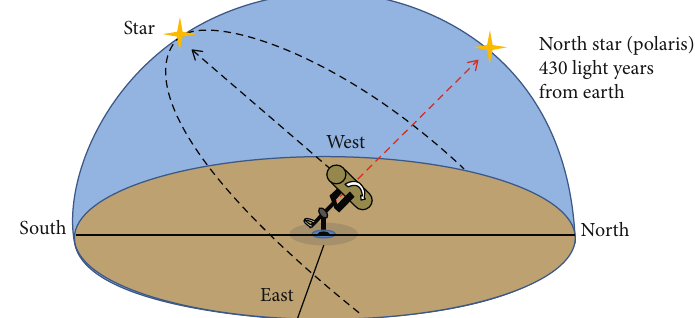
Figure 4: The tracking a telescope on an equatorial mount.